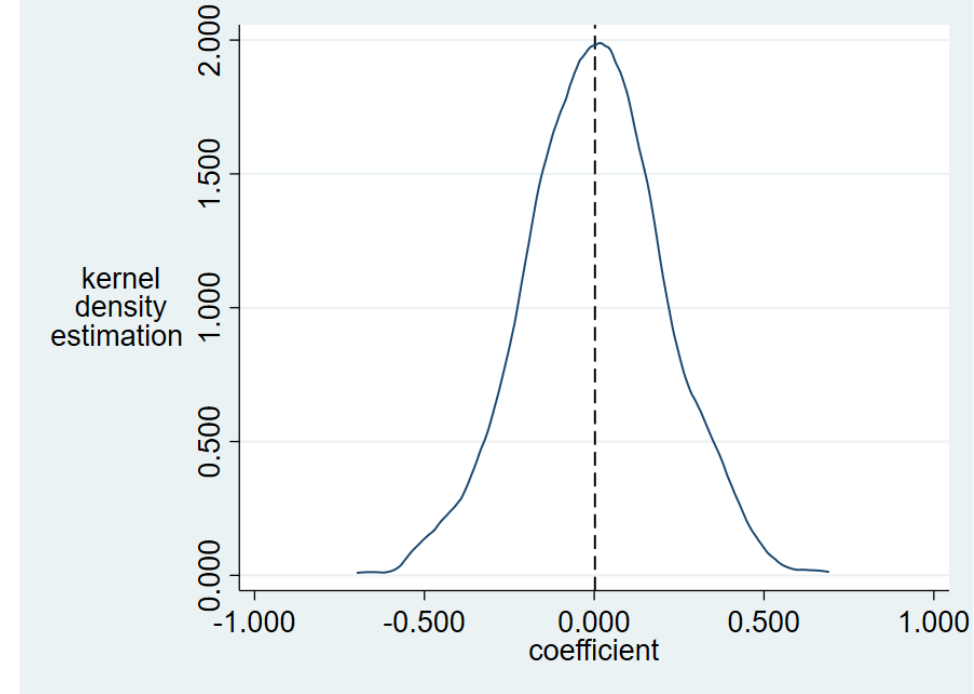
Figure 3. Plot of coefficient kernel density estimation for placebo test.